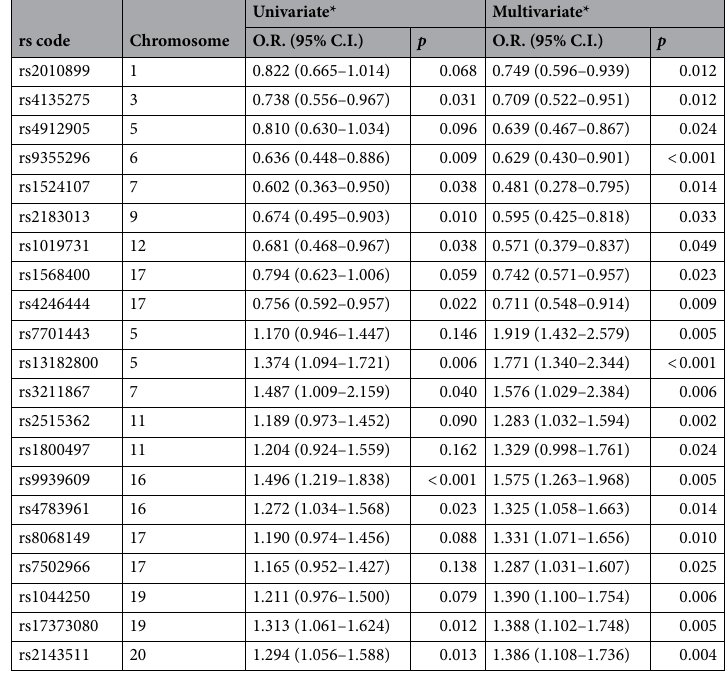
Table 2. Association of the 21 single nucleotide polymorphisms (SNPs) of the genetic risk score with OW/OB. SNPs ordered by chromosome number and protector/risk nature of the SNP. *Univariate (individual model of SNP-Overweight/Obesity association) and multivariate model (multiple model SNP-Overweight/Obesity association) displayed with Odds Ratio (O.R.) and 95% confidence interval (C.I.).